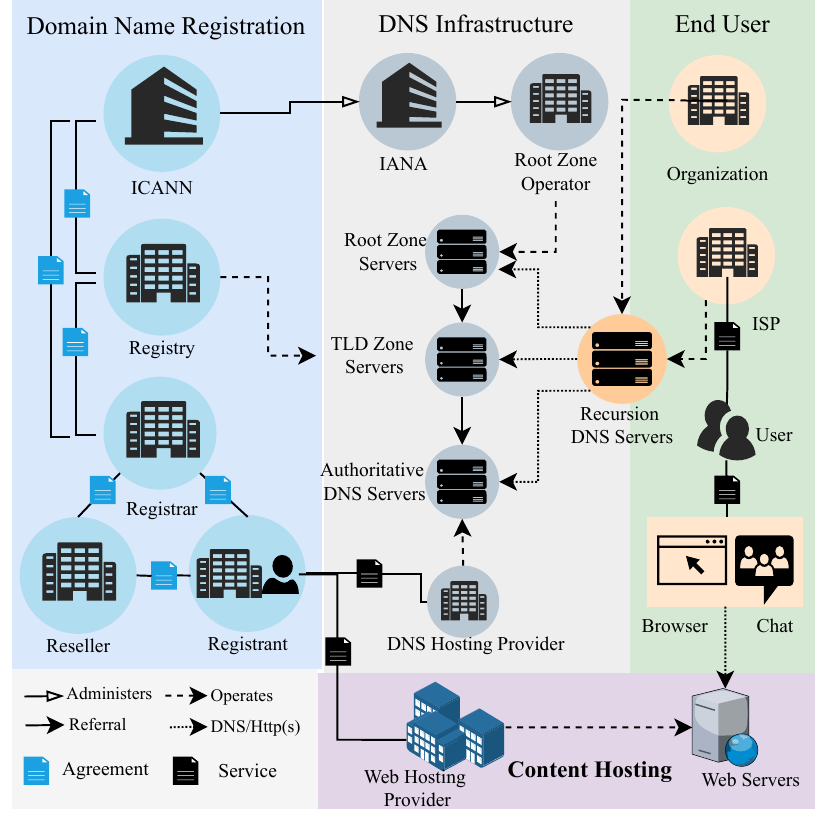
Figure 1. Conceptual diagram of the Internet ecosystem portion